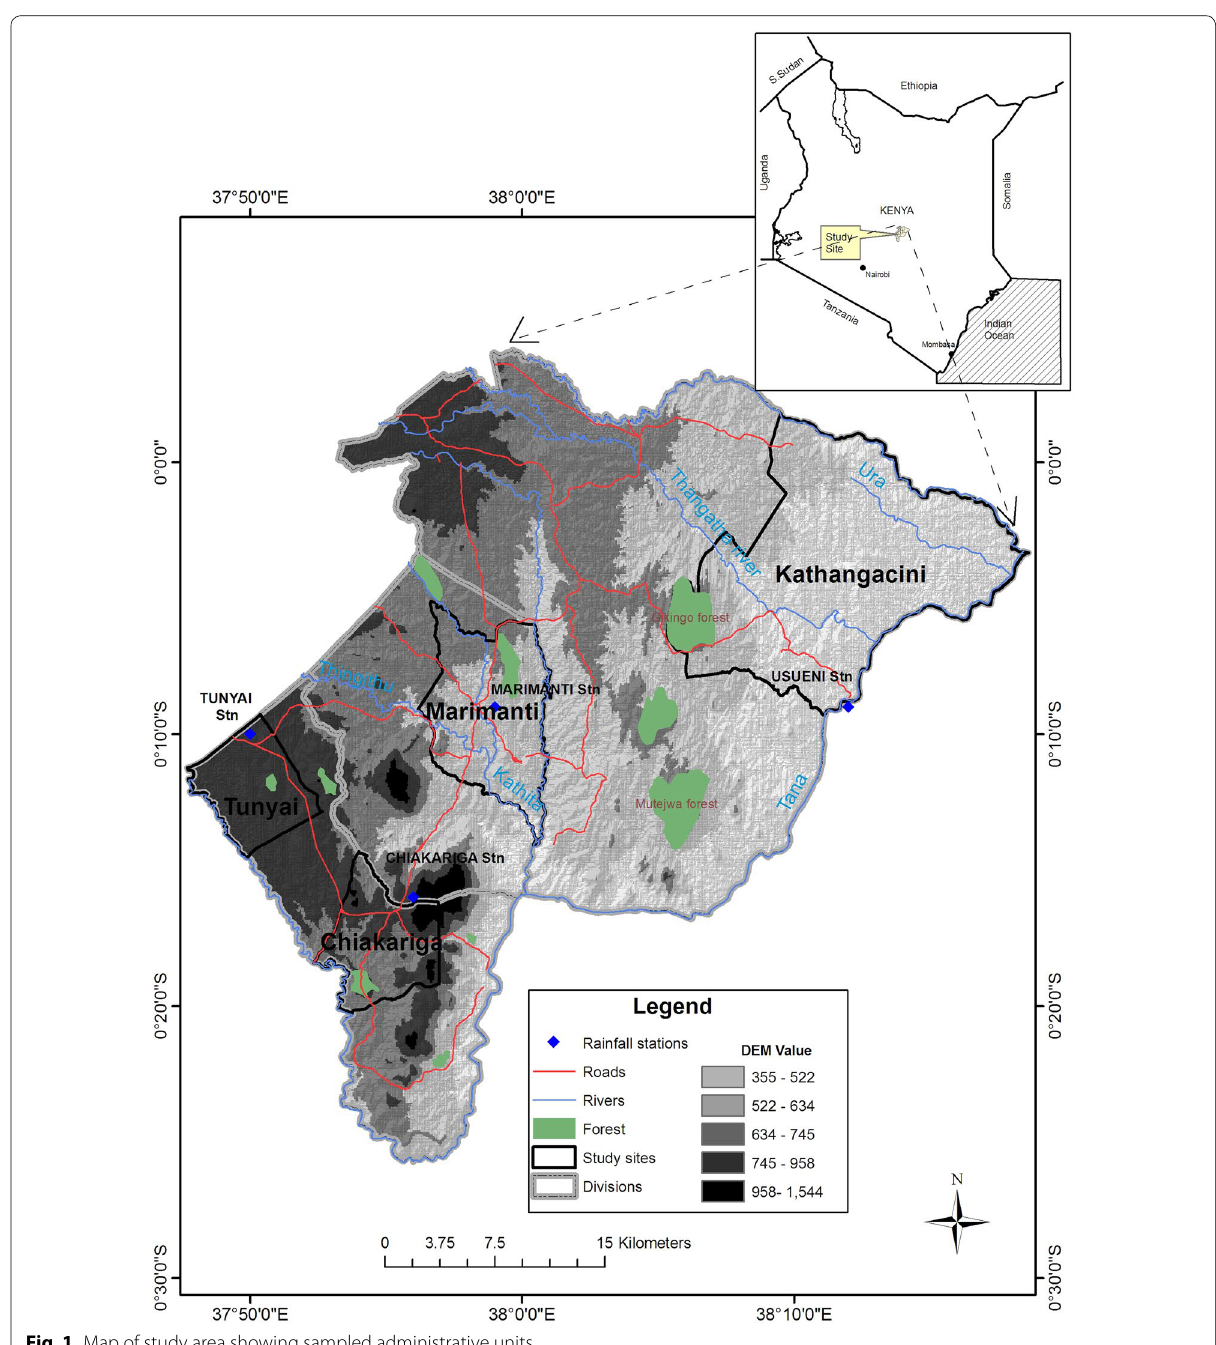
Fig. 1 Map of study area showing sampled administrative